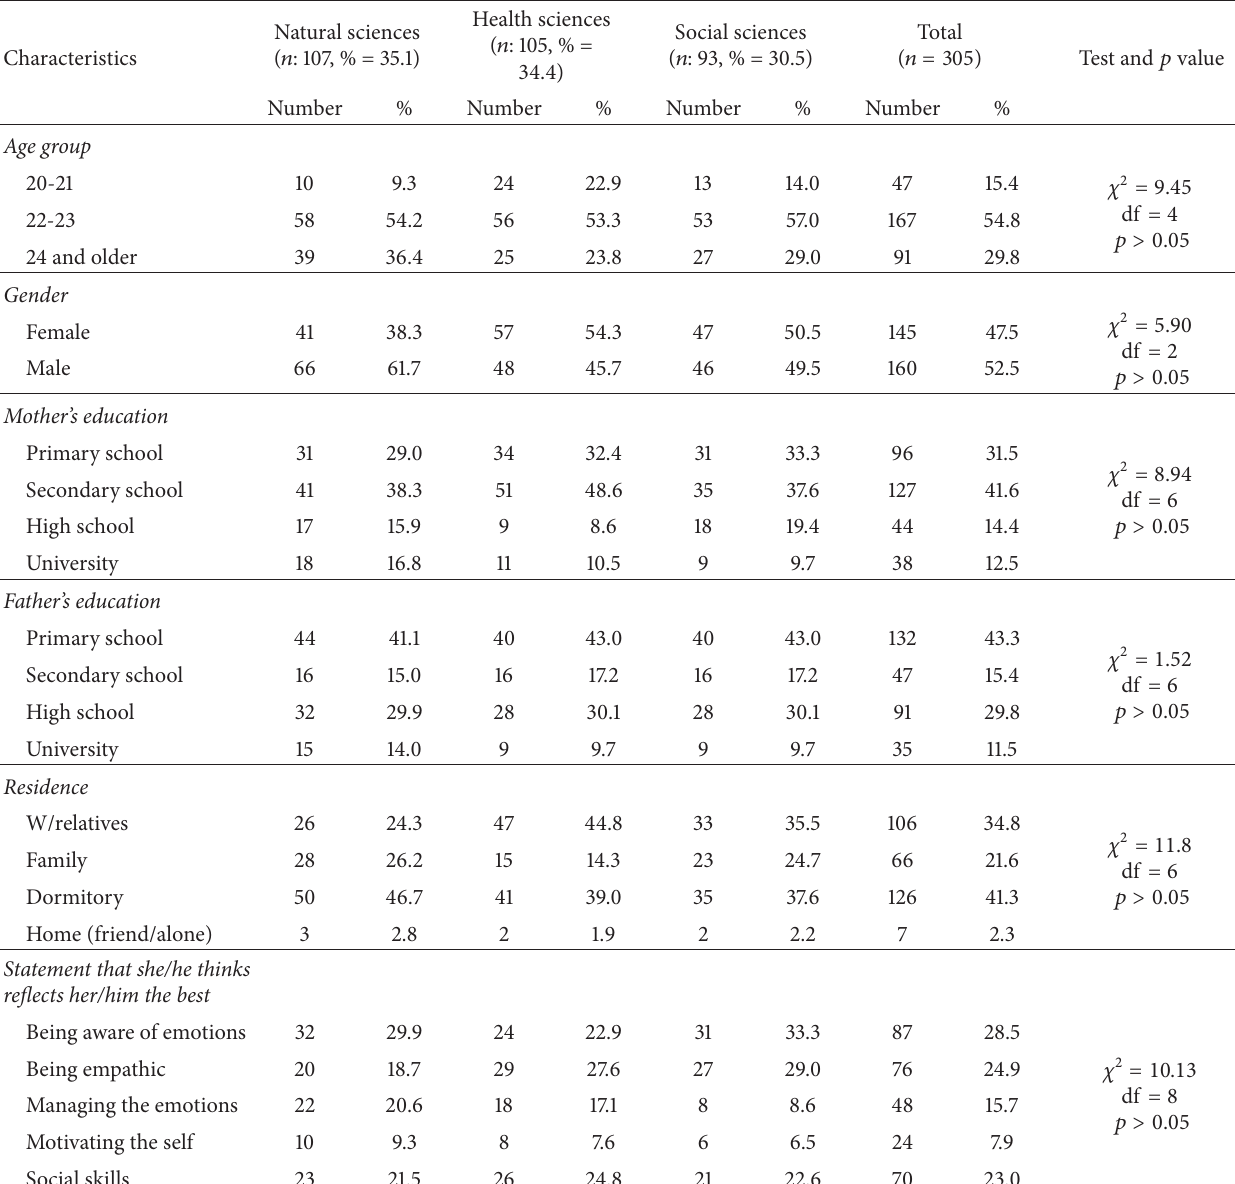
Table 2: Distribution of sociodemographic characteristics of